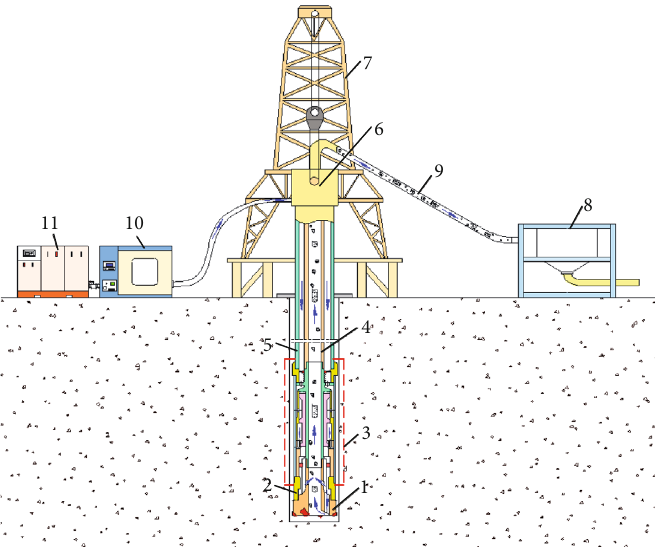
Figure 1: Reverse circulation drilling with DTH. 1: drill bit; 2: splined sleeve; 3: DTH; 4: inner drill pipe; 5: outer drill pipe; 6: swivel with double channels; 7: drill tower; 8: cyclone separator; 9: air hose; 10: air booster; 11: air